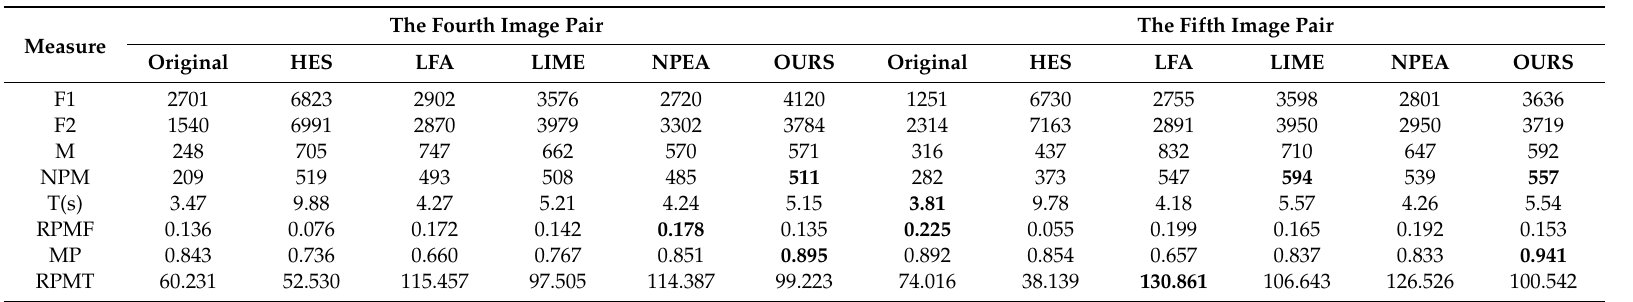
Table 4. Numerical performance indicators of SIFT for the fourth and fifth image